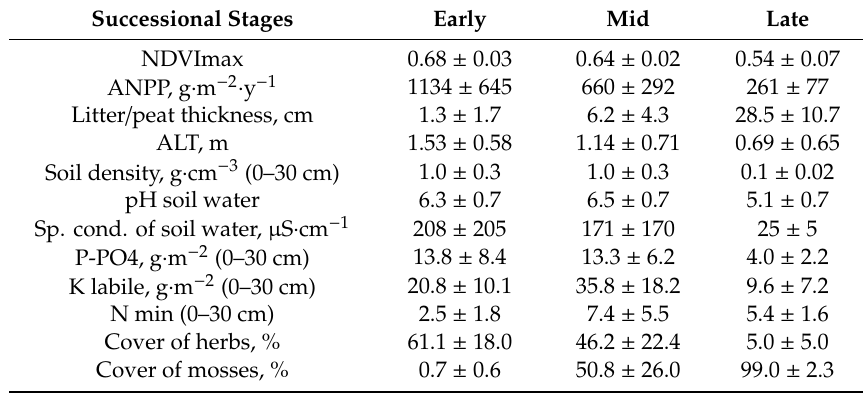
Table 1. Mean values and standard deviations (M ± sd) of soil and vegetation